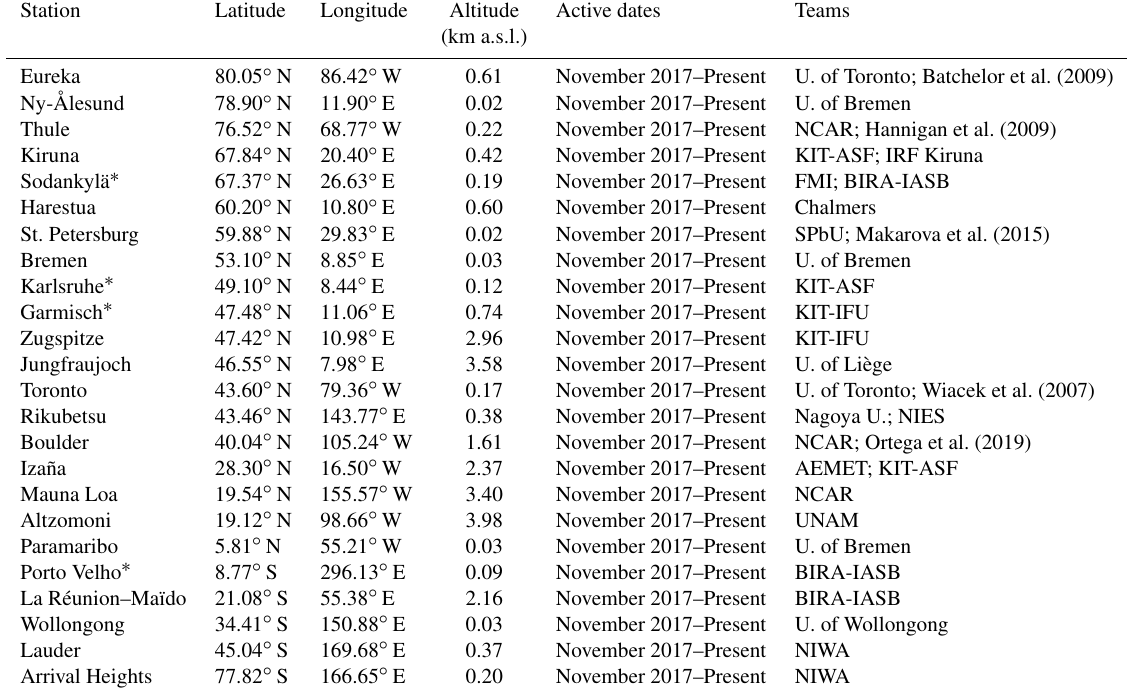
Table 3. List of FTIR stations that are associated with NDACC-IRWG and contributed to the present work by providing public and rapid delivery data. The stations marked with an asterisk ( ∗ ) are not yet associated with NDACC but perform observations and data analysis fully compatible with NDACC guidelines. The location of the stations and the teams involved are indicated for the respective stations.